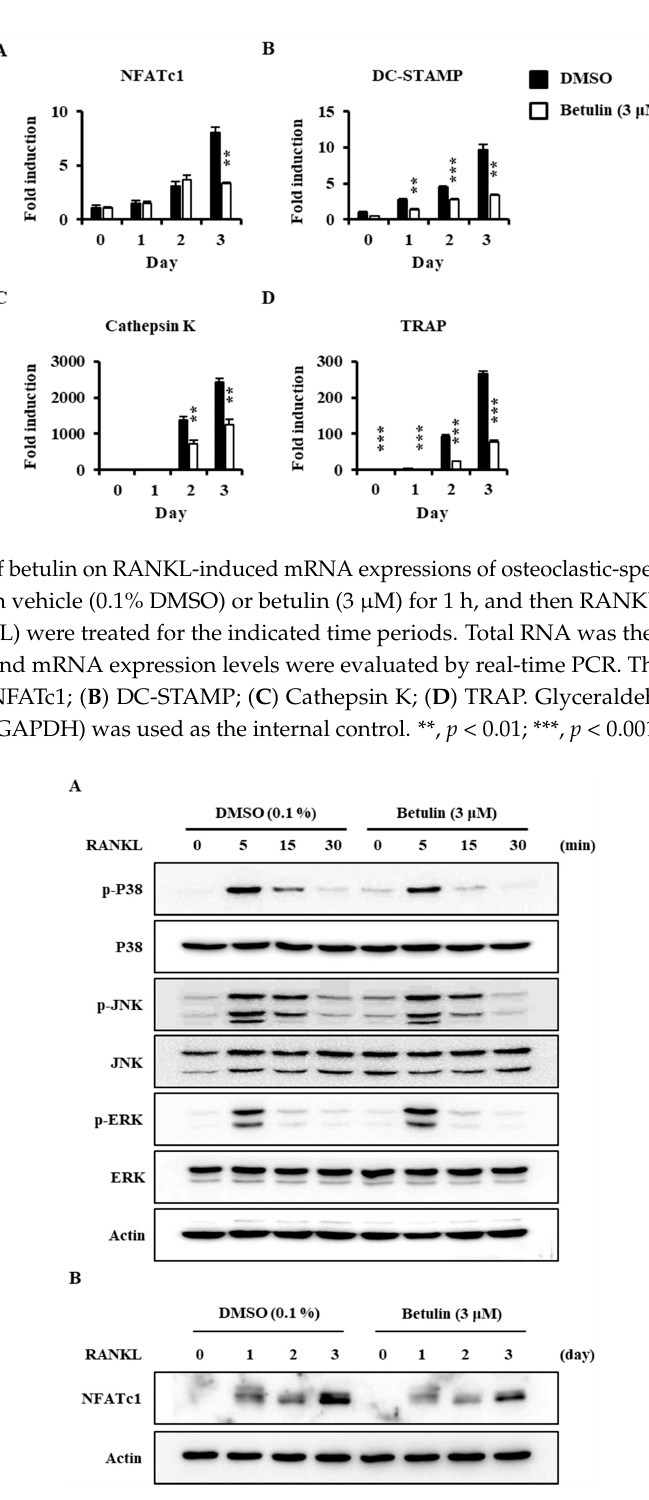
Figure 5. Betulin downregulated RANKL-mediated activation of NFATc1 through inhibition of p38 phosphorylation in BMMs. The effects of betulin on RANKL-induced phosphorylation of MAP kinases and degradation of I-kB and NFATc1 were evaluated by Western blot analysis. Actin was used as an internal control. ( A ) BMMs were pretreated with vehicle (0.1% DMSO) or betulin (3 μ M) for 1 h prior to RANKL (10 ng/mL) stimulation at the indicated time periods; ( B ) BMMs were treated with vehicle (0.1% DMSO) or betulin (3 μ M) for 1 h, and then RANKL (10 ng/mL) and M-CSF (30 ng/mL) were treated at the indicated time periods.